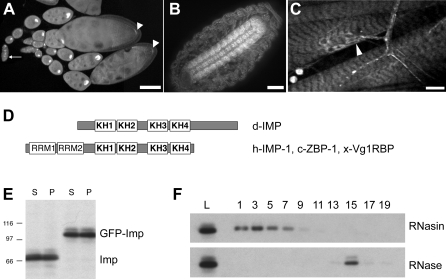
GFP-Imp Is Expressed in Ovaries and Neurons(A) In the ovary, GFP-Imp is detected within the germarium as early as stage 1 (arrow) and accumulates in the presumptive oocyte in early egg chambers. By stage 9–10, GFP-Imp is concentrated at the oocyte posterior pole (arrowheads). Bar, 25 μm.(B) GFP-Imp is enriched in the embryonic central nervous system (Bar, 25μm), and (C) in larval segmental axons and at the synapse (arrowhead). Bar, 5μm.(D) Schematic highlights the domain structure of Drosophila Imp compared to orthologs in human, chick, and Xenopus. RRM = RNA recognition motif. KH = hnRNP K homology domain.(E) The insertion of the PTT does not alter the level of Imp protein expression. Ovary extracts from wild type and GFP-Imp flies show similar levels of overall expression, as well as similar relative expression in supernatant (S) and pellet (P) fractions, as detected by an anti-Imp antibody.(F) GFP-Imp is present in a large, RNase-sensitive complex. GFP-Imp ovary extracts were fractionated over a 10%–40% sucrose gradient in the presence of RNase, or RNase inhibitors. Equal volumes of alternate fractions were analyzed by western blot using anti-GFP antibody. Lane L, sample of extract loaded on gradient. Fraction numbers are indicated above the lanes (bottom of gradient is fraction 1).